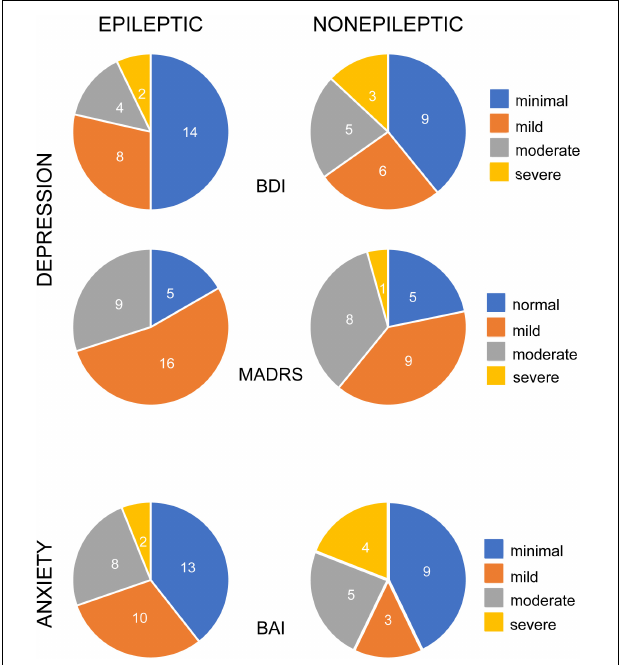
FIGURE 1 | Occurrence of depression and anxiety symptoms in patients with epileptic and non-epileptic seizures. Pie charts illustrate the percentage of epileptic (left column) and non-epileptic (right column) patients with self-reported symptoms, color coded for degree of severity, as indicated. Depression symptoms were evaluated with the Becks Depression Index-II (BDI, upper row, n = 28 ES, 23 NES) and the Montgomery-Asberg Depression Rating Scale (MADRS, middle row, n = 30 ES, 23 NES). Anxiety symptoms were evaluated with the Beck Anxiety Inventories (BAI, bottom row, n = 33 ES, 21